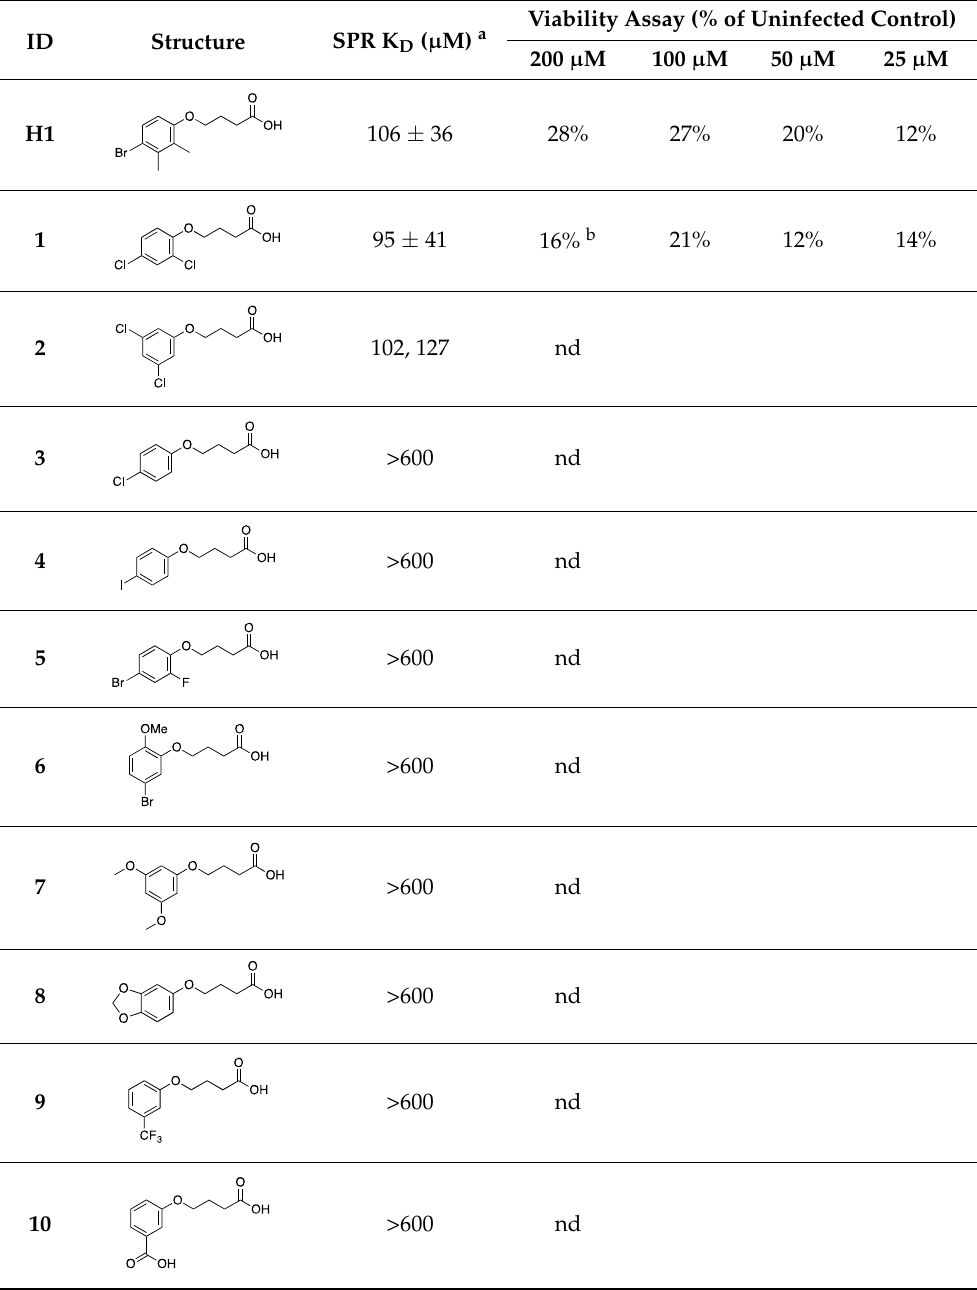
Table 1. K D and biological evaluation of the synthesized compounds. ID